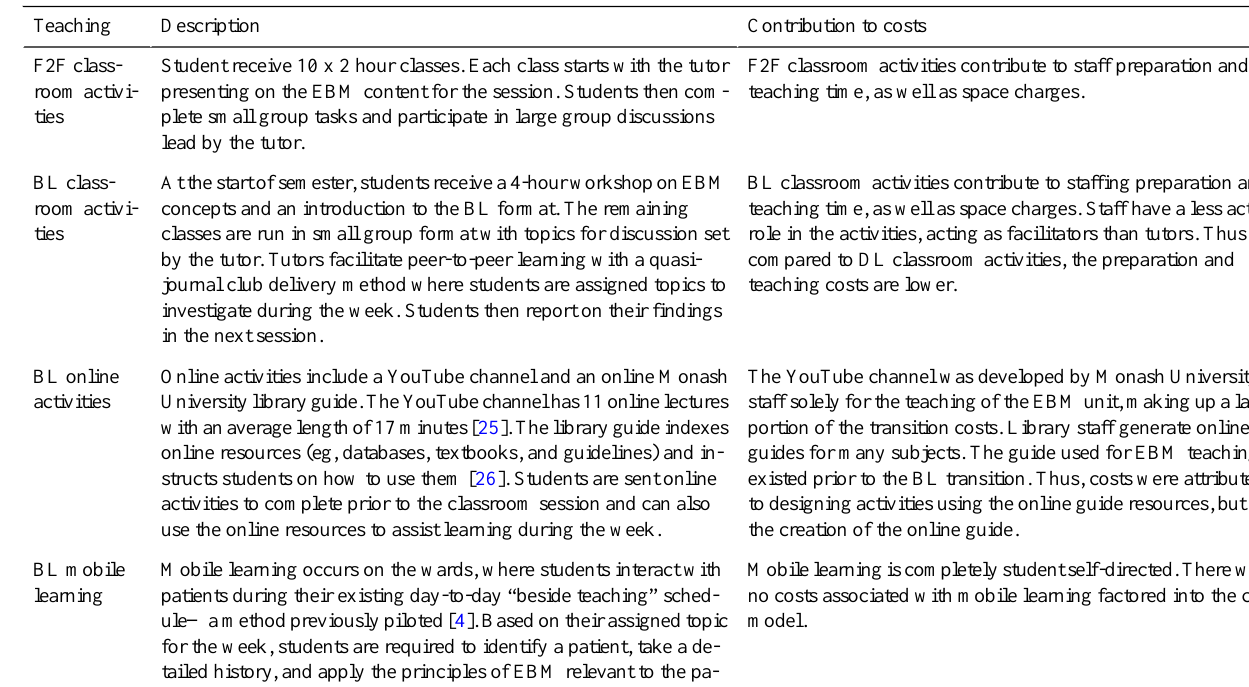
Figure 1. Equation for the calculation of the incremental cost for each quality-adjusted student educated